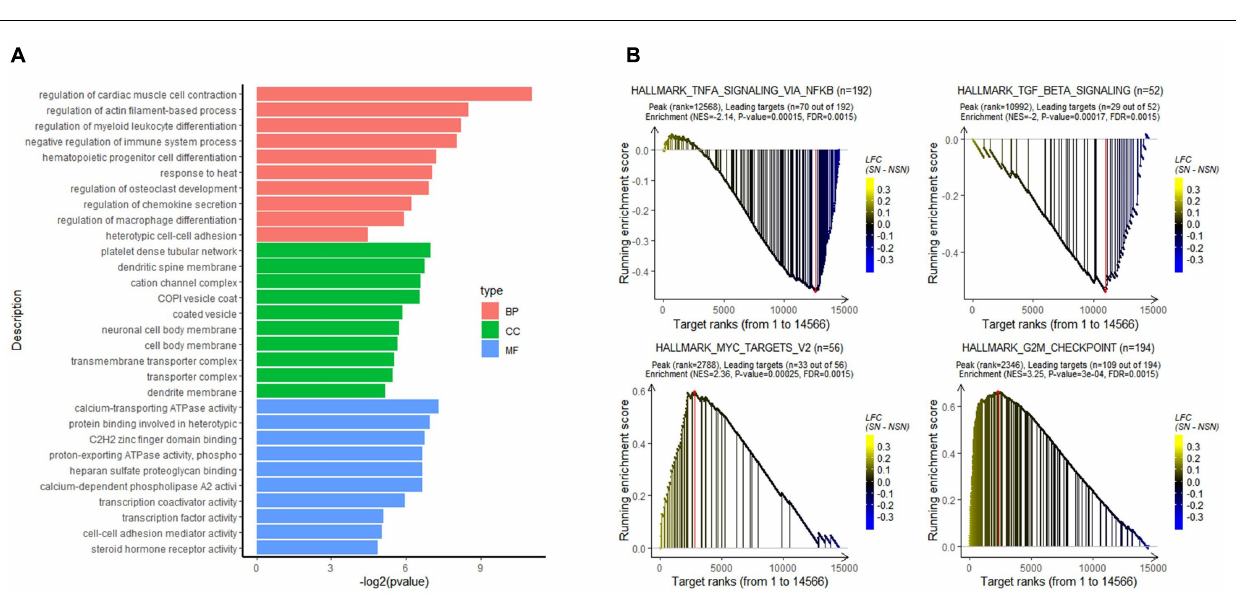
Frontiers in Cell and Developmental Biology |